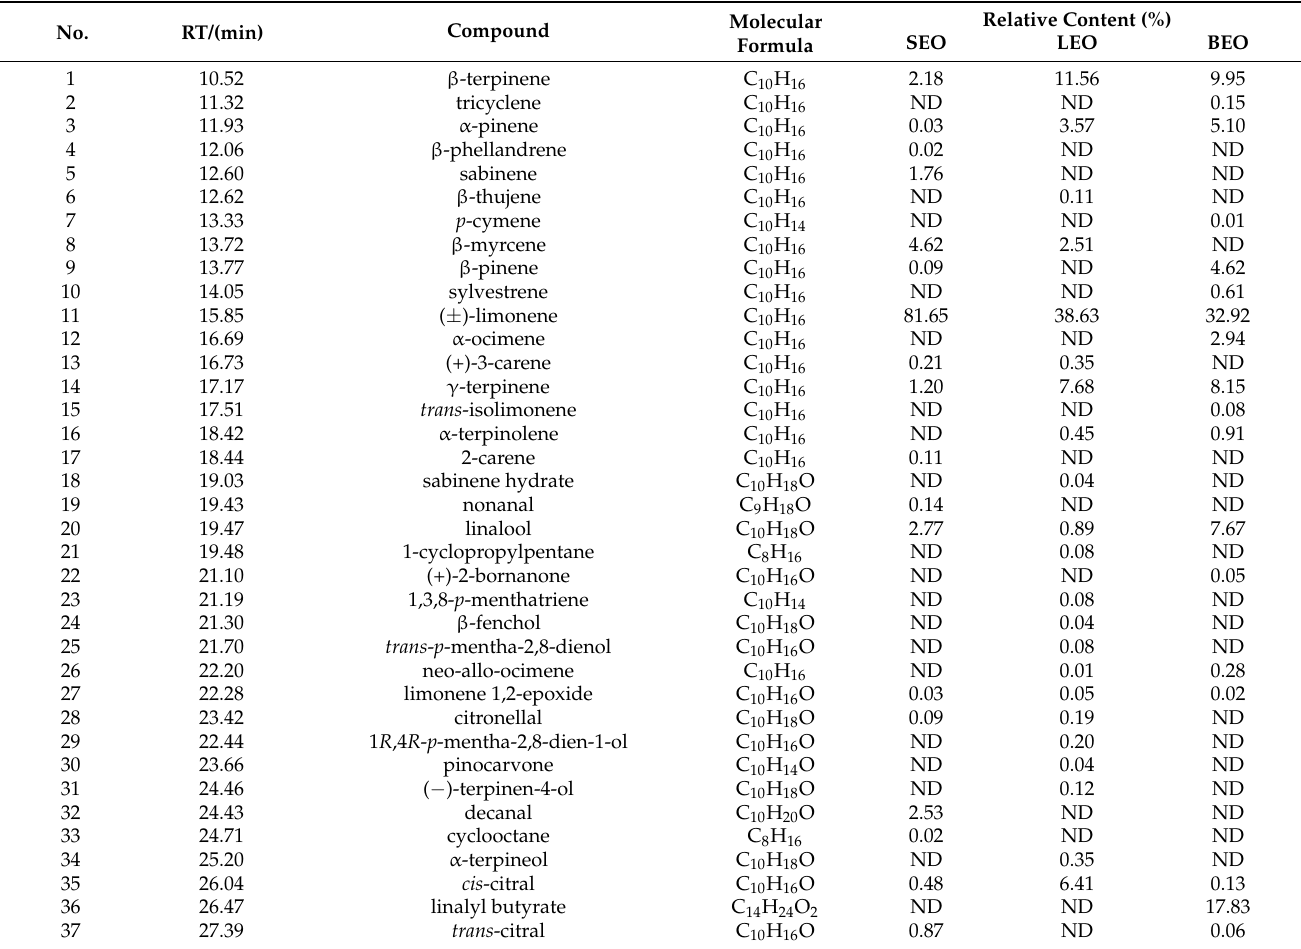
Table 1. Chemical composition of sweet orange ( Citrus sinensis L.), lemon ( Citrus limon Osbeck ), and bergamot ( Citrus bergamia Risso and Poit ) essential